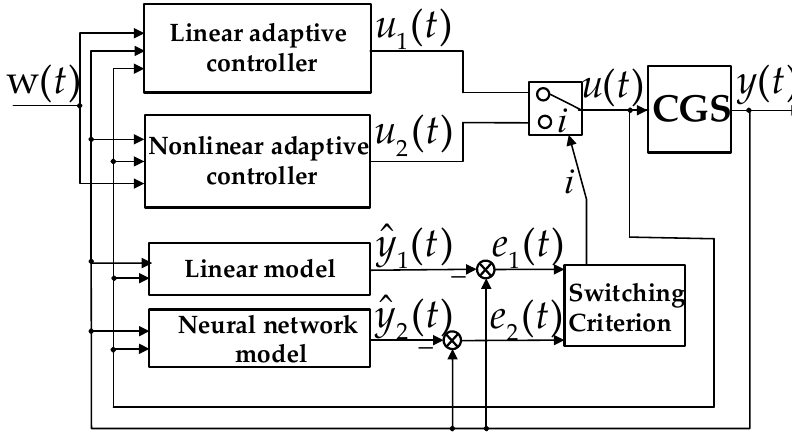
Figure 7. Switching mechanism based on multiple model.